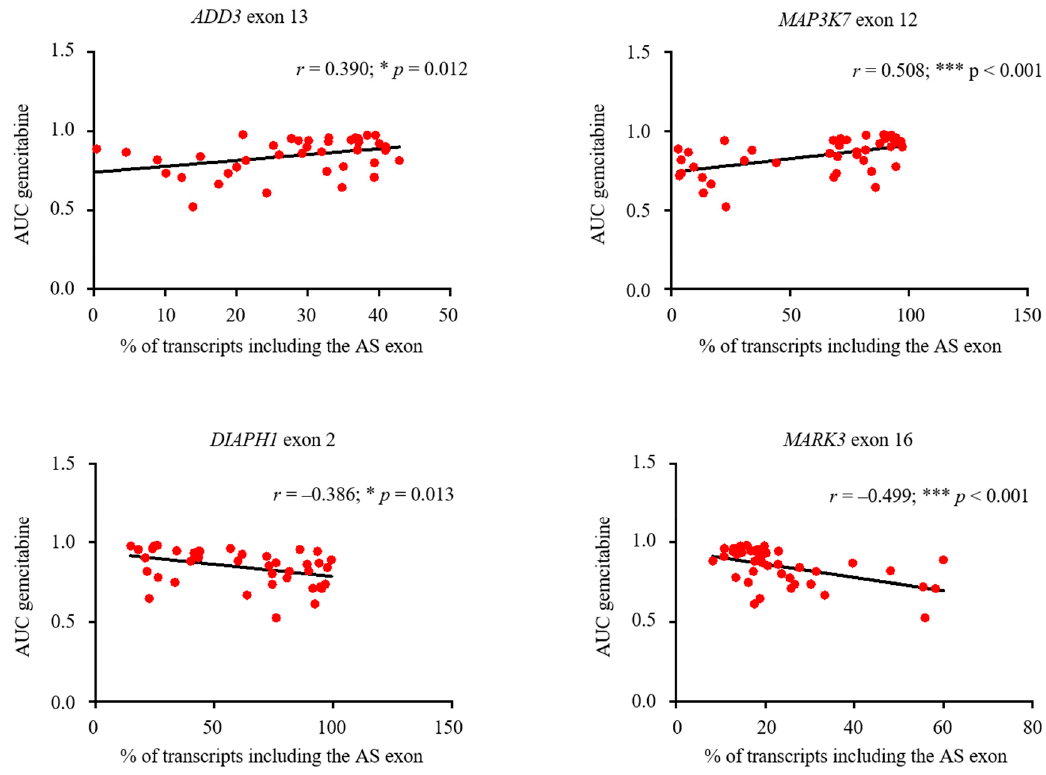
Figure 7. Correlation of IDR-encoding AS events and gemcitabine sensitivity in breast cancer cells. ADD3 exon 13, MAP3K7 exon 12, DIAPH1 exon 2, and MARK3 exon 16 containing isoforms (% of transcripts) and gemcitabine sensitivity (AUC, area under the dose–response curve) correlation in 41 breast cancer cell lines. Pearson coefficient (r) and linear regression are also shown. *** p < 0.001; * p < 0.05.